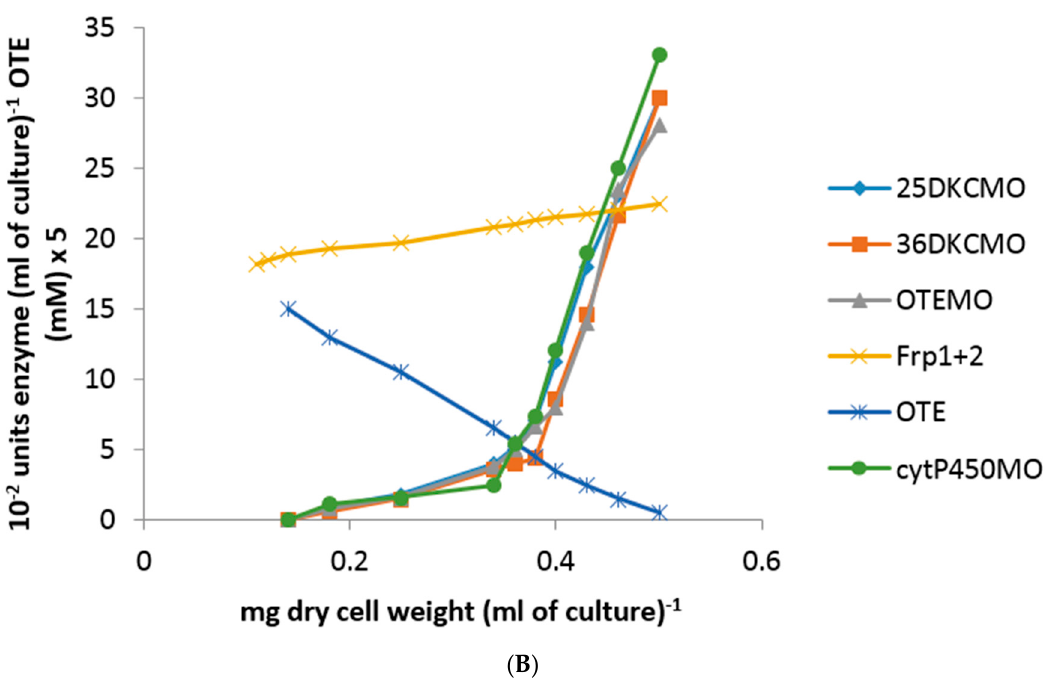
Figure 3. ( A ) Changes in the optical density (A 500 nm) of P. putida NCIMB 10007 following addition of 2,5-DKC as inducer-substrate to succinate minimal medium and concomitant changes in the activity of key enzymes and metabolic intermediates of the camphor degradation pathway. An almost identical pattern of changes was recorded when 3,6-DKC was substituted for 2,5-DKC [23]; ( B ) Changes in the optical density (A 500 nm) of P. putida NCIMB 10007 following addition of OTE as inducer-substrate to succinate minimal medium and concomitant changes in the activity of key enzymes and metabolic intermediates of the camphor degradation pathway.